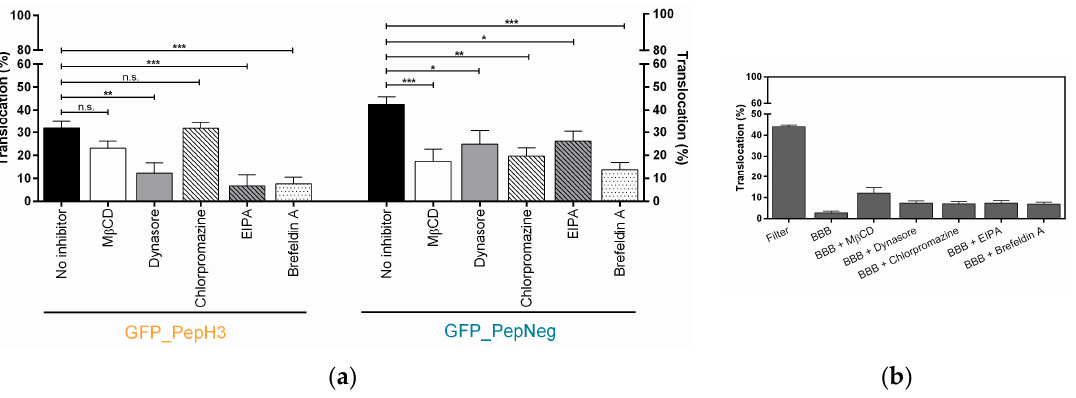
Figure 3. Screening of GFP_PepH3 and GFP_PepNeg translocation, in the presence of endocytosis inhibitors, and the barrier-integrity studies. ( a ) Percentage of translocation for GFP_PepH3 (orange) and GFP_PepNeg (blue), determined by GFP fluorescence intensity detection at 37 °C in the presence of the following inhibitors: M β CD (5 mM, white bars), dynasore (50 μ M, grey bars), chlorpromazine (50 μ M, white-dashed bars), EIPA (100 μ M, grey-dashed bars) and brefeldin A (10 μ g/mL, white-dotted bars). A one-way ANOVA statistical test followed by a Dunnett’s test was used to compare each fluorescence measurement with the respective experiments at 37 °C with no-inhibitor (black bars; * p ≤ 0.05; ** p ≤ 0.01; *** p ≤ 0.001; n.s., not significant); ( b ) Percentage of BBB permeability to FD40, determined by fluorescence intensity measurements. The recorded percentages were compared to two controls: the transwell without cells (“Filter”) and the other consisting of the barrier model without peptide at 37 °C (“BBB”). The values were obtained from duplicates of two independent experiments.